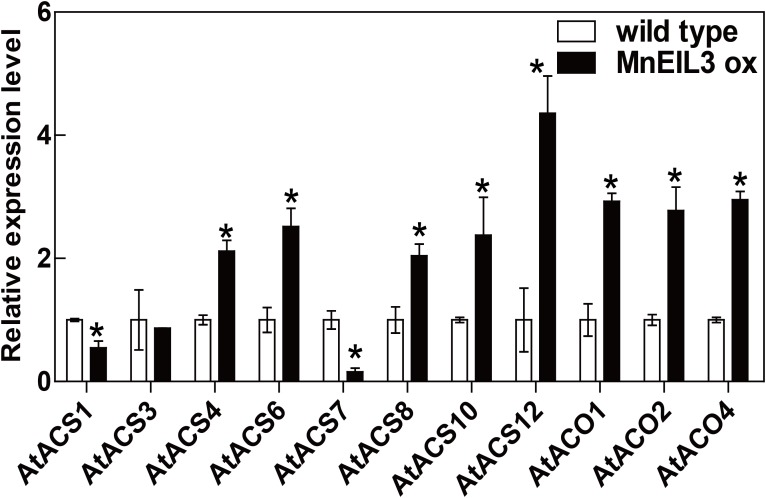
qRT-PCR analysis of changes in AtACS and AtACO genes in MnEIL3ox plants.Data are means ± SEs (n = 3). Significant differences (P < 0.05) are marked with asterisks. The gene expression in wild type was set as 1.